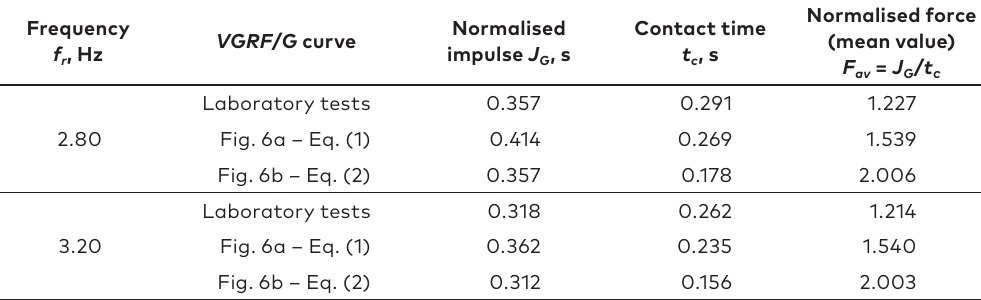
Table 3. Parameters of the VGRF/G curves presented in Figure